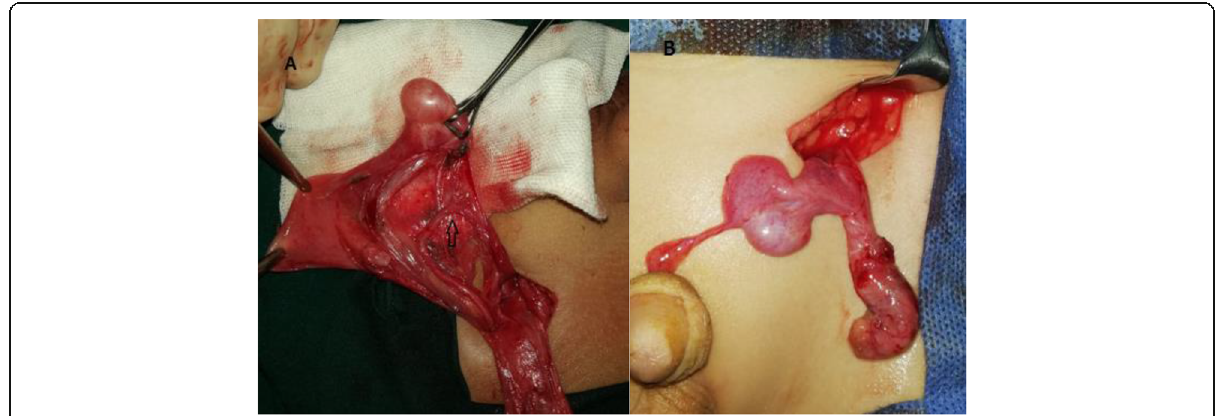
Fig. 3 a Completely separated testis (Babcock forceps) from the epididymis (non-toothed forceps); congenital curled vas deferens (black arrow) is also separated from the tail of the epididymis. b Enlarged stalked epididymal